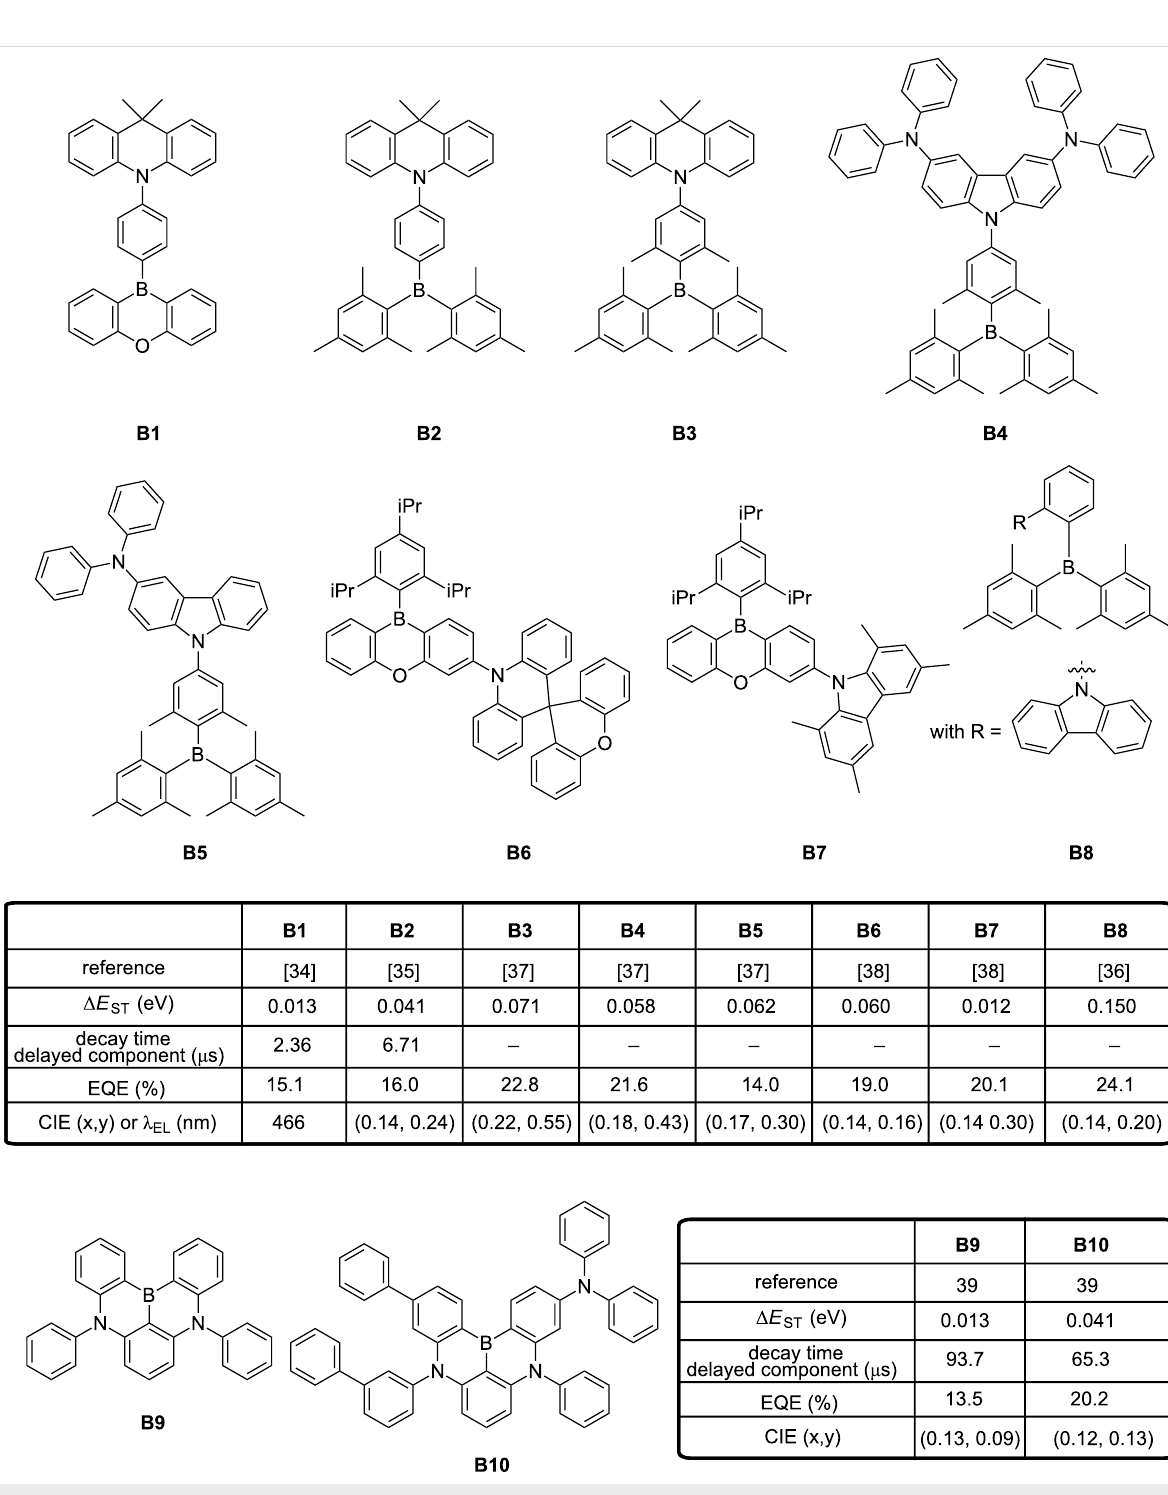
termined for B1 and B2 , respectively, calculated from the difference existing between the onset of the fluorescence and the phosphorescence emission. The decay time of the delayed component of luminescence was determined as being 2.36 μ s